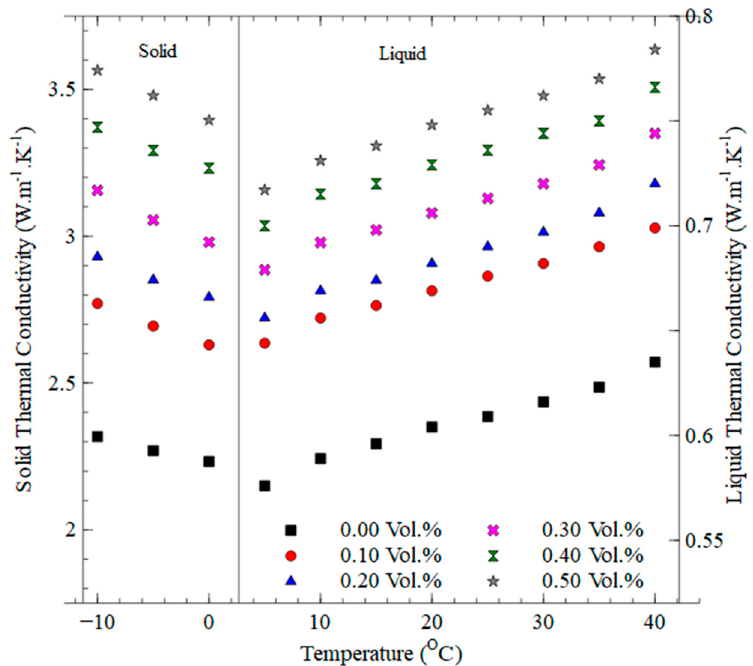
Figure 4. Variation of thermal conductivity with respect to temperature for different volume percentages .